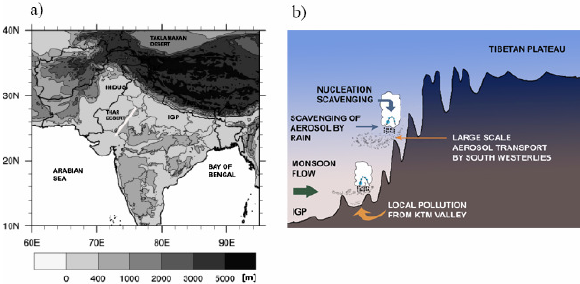
Figure 1a): The Tibetan plateau and the Himalayas are unique features of Asia with the Indian Gangetic Plain (IGP) and Indus river basin on the southern slopes and Takla Makan desert on the northern slopes of the Tibetan plateau. Thar desert lies on the western slopes of the Aravalli range (straight white strip). Elevation contours are plotted at 400, 1000, 2000 , 3000 and 5000 m. Topography was obtained from the USGS gtopo30 data. b): Processing of aerosols by clouds along the North-South cross-section passing through Kathmandu Valley in Central Nepal.